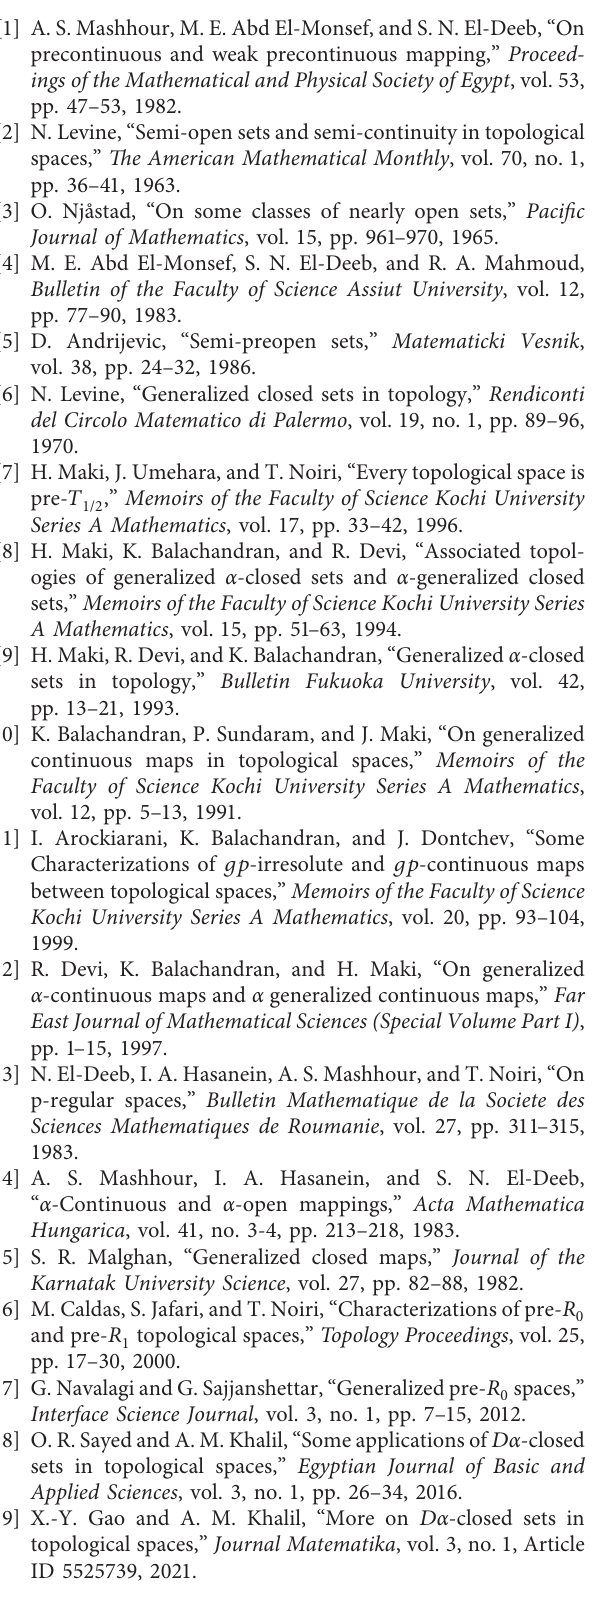
p -closed sets and other sets.